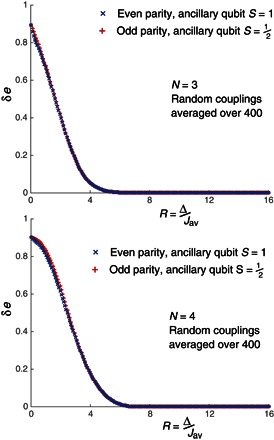
Energy levels at the end of the adiabatic sweep.Deviation between the lowest energy gap in the logical Hamiltonian Hlogic and the physical Hamiltonian Hphys as a function of the constraint’s strength. These graphs demonstrate that the even- and odd-parity variants perform almost identically.